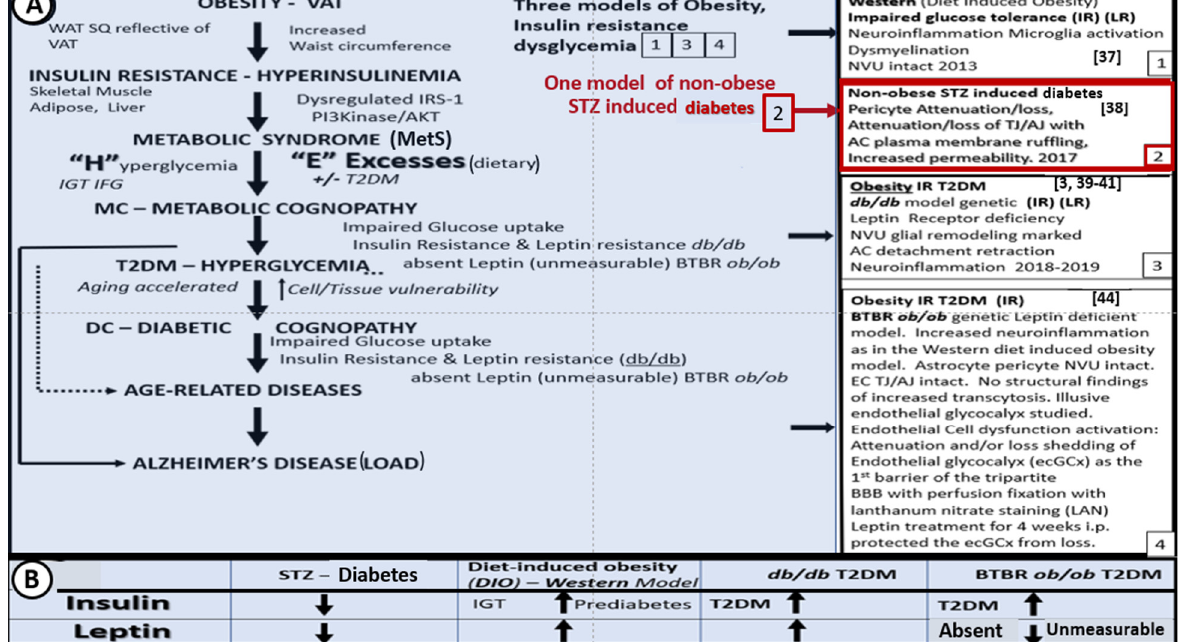
Figure 2. Brain ultrastructural remodeling in obesity models studied to date with insulin and leptin levels for comparison. Panel A depicts the importance of obesity, insulin resistance-deficient leptin cellular signaling in regards to the development of age-related diseases such as late onset Alzheimer’s disease (LOAD) and neurodegeneration (left-hand side blue coloration). Boxes 1, 3, and 4 (right-hand side) all share deficient cellular leptin signaling. Box 2 depicts the streptozotocin induced insulinopenic diabetes mellitus (DM). Panel B illustrates the increased (upward arrows) and decreased (downward arrows) of insulin and leptin in each model discussed in Panel A. AC = astrocyte; AJ = adherens junction; AKT = protein kinase B; EC = endothelial cell; IFG = impaired fasting glucose; IGT = impaired glucose tolerance; i.p. = intraperitoneal; IRS − 1 = insulin receptor substrate − 1; LAN = lanthanum nitrate; NVU = neurovascular unit; PI3Kinase = phosphoinositide 3-kinase; T2DM = Type 2 diabetes mellitus; SQ = subcutaneous fat; TJ = tight junction; VAT = visceral adipose tissue; WAT = white adipose